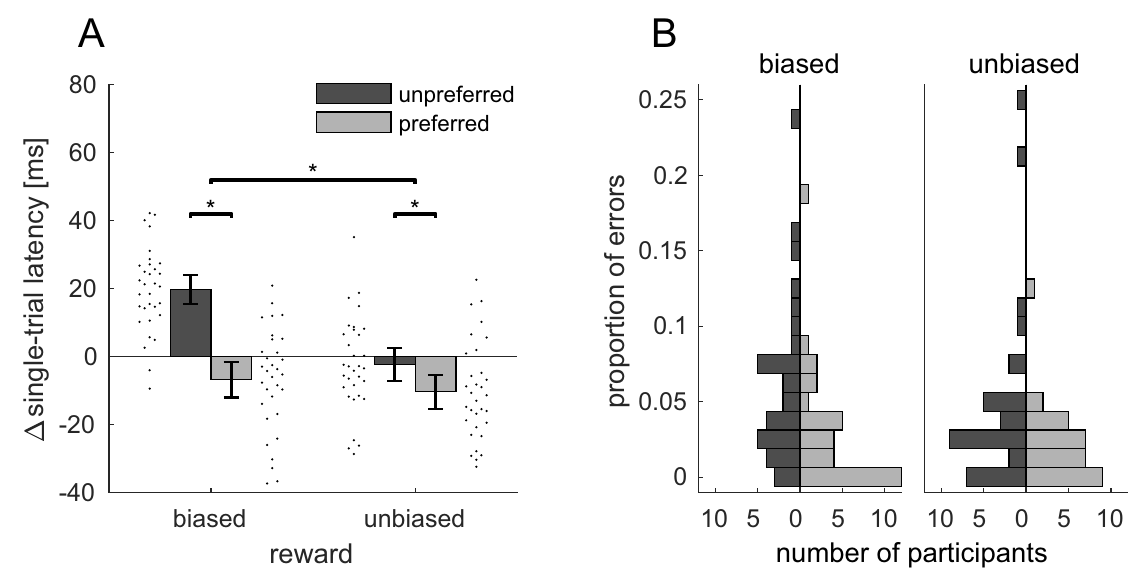
Fig 3. Single-trial behavior. Single-trial latencies (A) and errors (B) for preferred (light) and unpreferred (dark) targets. (A) Single-trial latencies in every condition are expressed as the difference from the individual mean. Black dots next to each bar graph denote values of individual participants in that respective condition. Error bars denote 95% confidence intervals of between-participant variability. Asterisks indicate significant (p < 0.05) comparisons. (B) vertical histogram of the proportion of single-trial errors.